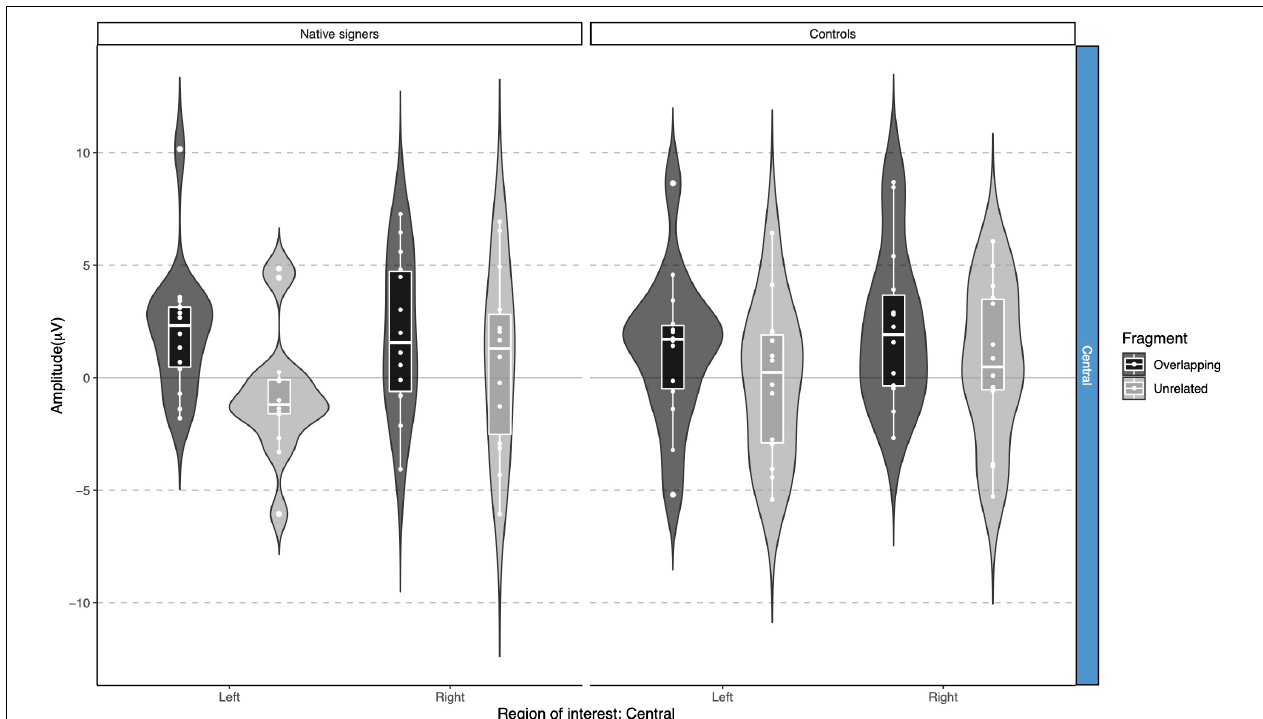
FIGURE 8 | Violin-boxplots depicting mean amplitude for the P350/positivity in the 400–600 ms time window for Native signers (left) and Controls (right) for the Unrelated (light gray) and Overlapping (dark gray) fragments across regions of